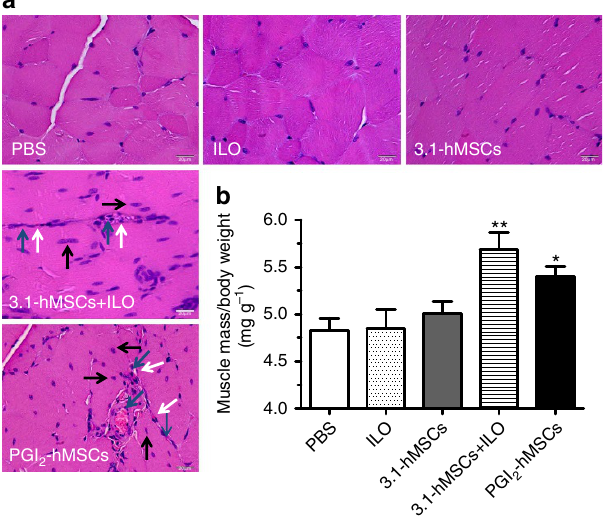
Figure 3 | PGI 2 -hMSC treatment led to host regeneration and muscle mass gain. ( a ) Haematoxylin and eosin (H&E) stain showed regenerating myofibers with centralized nuclei (black arrows) next to microvessels (white arrows) containing red blood cells (blue arrows) at day 14 in mice treated with 3.1-hMSCs þ ILO or PGI 2 -hMSCs. ( b ) Muscle mass relative to body weight. Both 3.1-hMSCs þ ILO- and PGI 2 -hMSC-treated mice had significant muscle mass gain in the gastrocnemius muscle in ischaemic hindlimbs as compared with the three other treatments after 1 month. ** P o 0.01, 3.1-hMSCs þ ILO versus ILO, versus 3.1-hMSCs or versus PBS; * P o 0.05, PGI 2 -hMSCs versus ILO, versus 3.1-hMSCs or versus PBS by a one-way ANOVA with Newman–Keuls post hoc test. Data are shown as mean ± s.e.m. N ¼ 9 mice/PBS; N ¼ 5 mice/ILO; N ¼ 10 mice/3.1-hMSCs; N ¼ 10 mice/3.1-hMSCs þ ILO; N ¼ 10 mice/PGI 2 -hMSCs. Both male and female mice were used. Scale bar, 20 m m. NATURE COMMUNICATIONS|7:11276|DOI: